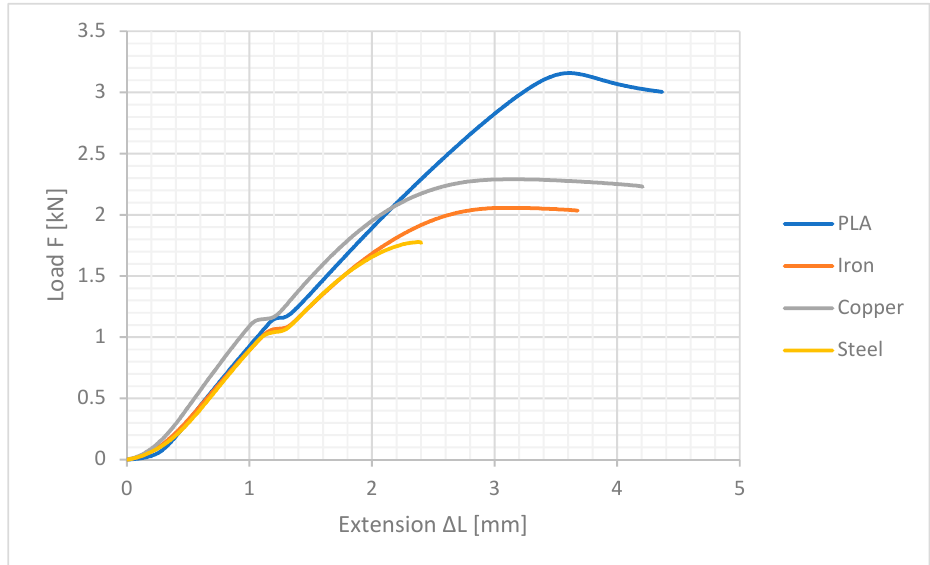
Figure 17. Tensile test load-extension curves for material printed at 0° print orientation.